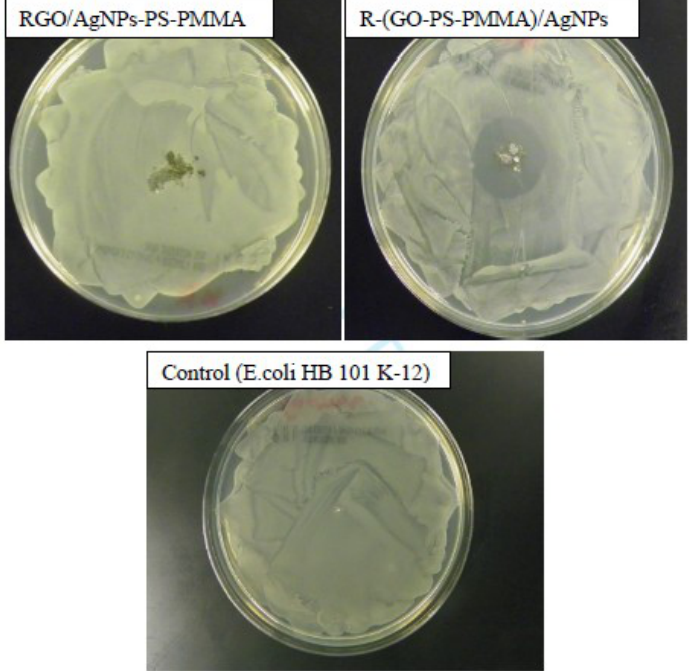
Figure 10. Kirby–Bauer antibacterial strength measurements for RGO/AgNPs-PS-PMMA and R-(GO-PS-PMMA)/AgNPs against E. coli HB 101 K-12.